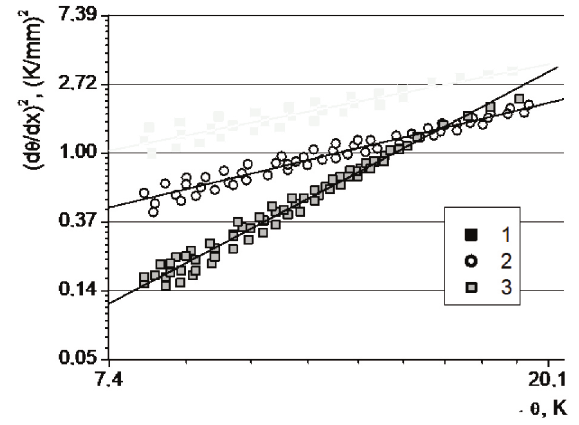
Figure 6. Superheat gradient vs. superheat for the porous coatings and the smooth surface (3K < q < 17K); distilled water boiling: 1 – metal-fibrous microstructure of 81% porosity, 2 – metal-fibrous microstructure of 67% porosity, 3 – smooth surface